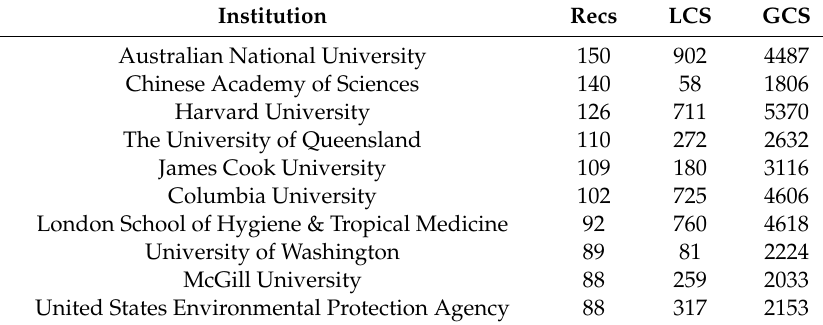
Table 1. List of the top 10 institutions with their numbers of published